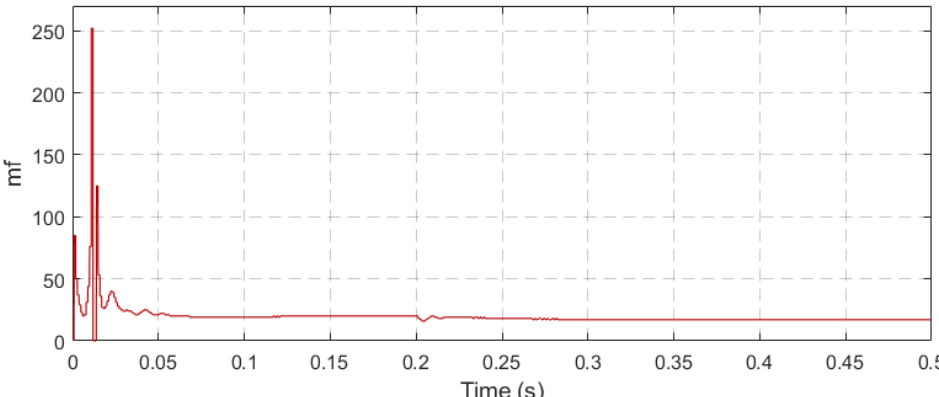
Figure 23. m f , ratio of PWM, and fundamental supply frequencies before and after a rated load torque step is applied at t = 0.2 s.